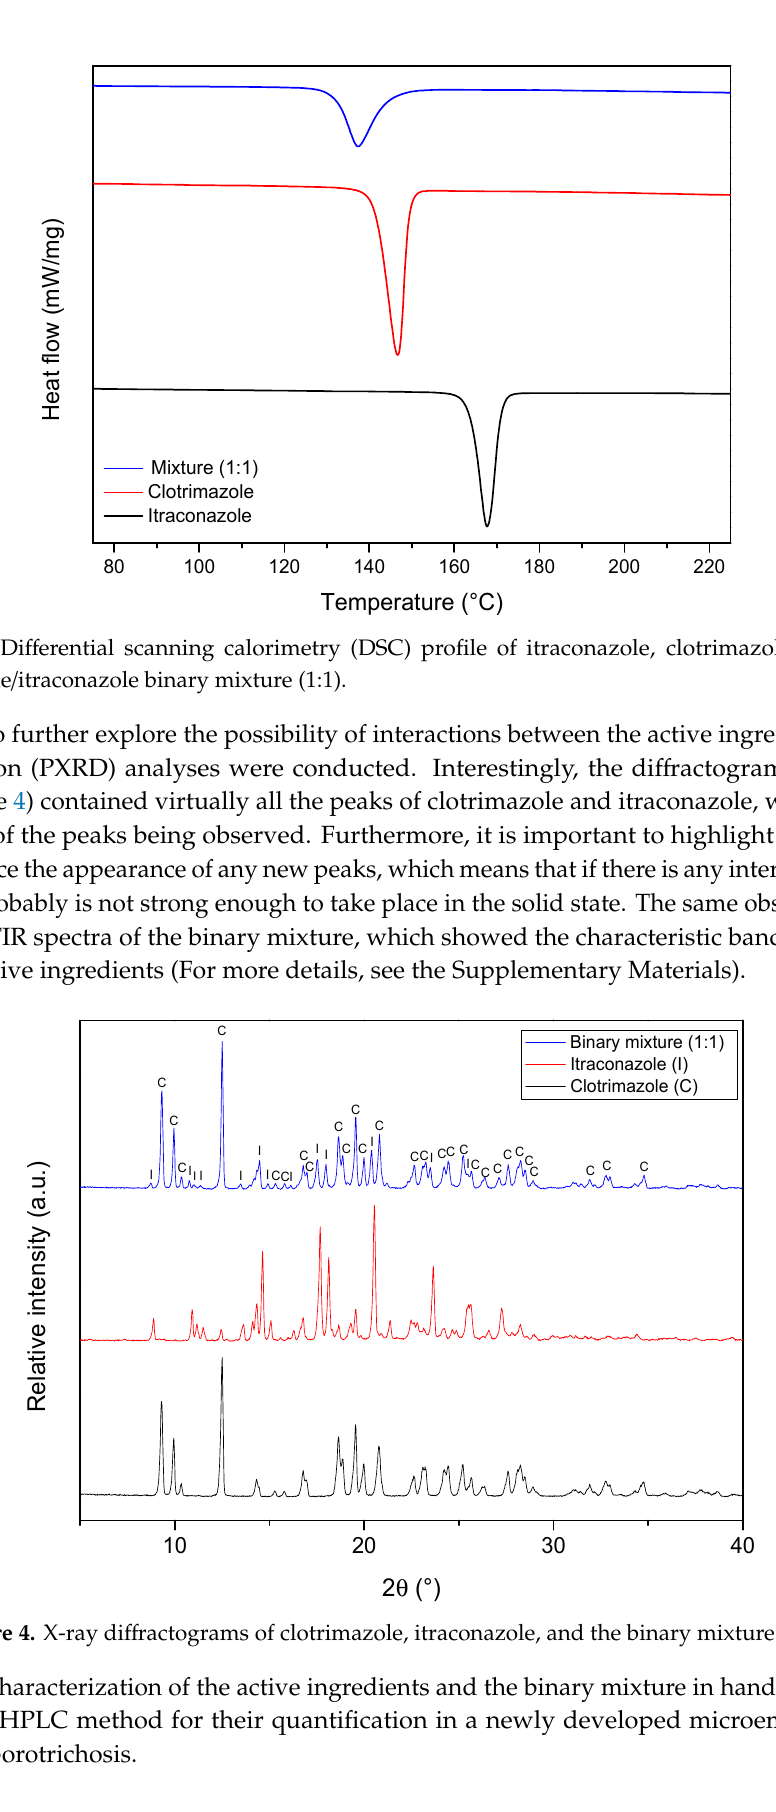
Figure 4. X-ray diffractograms of clotrimazole, itraconazole, and the binary mixture (1:1).